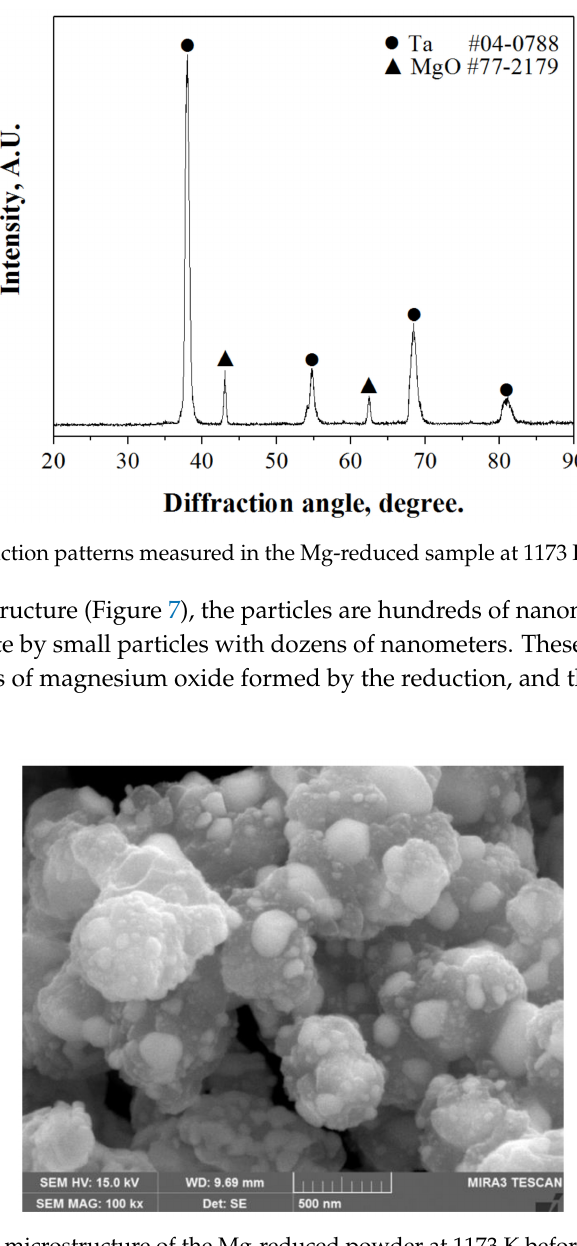
Figure 7. SEM microstructure of the Mg-reduced powder at 1173 K before acid